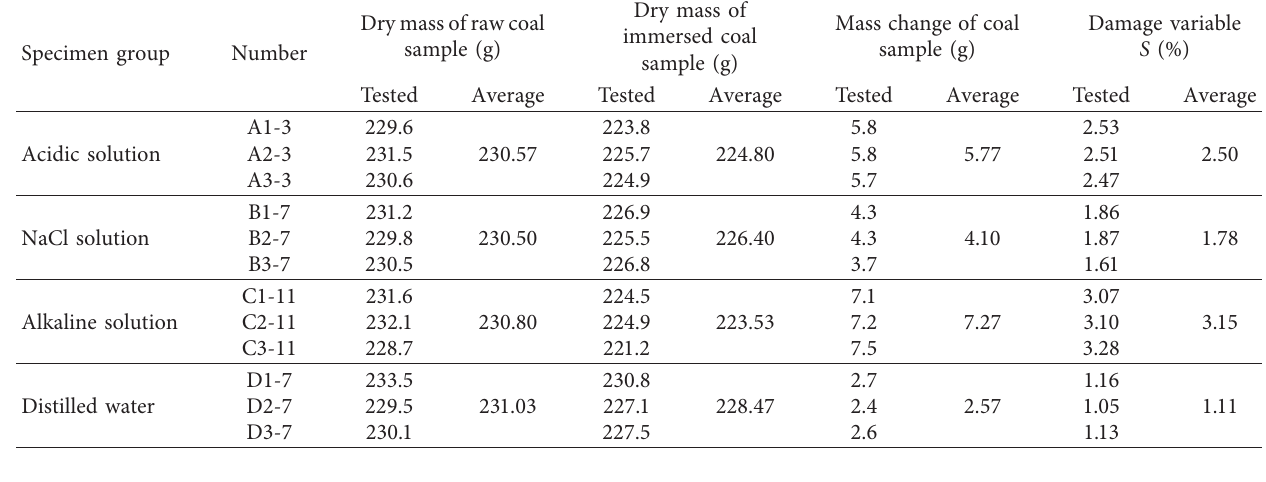
Table 1: Mass parameters of coal samples under static load tests.